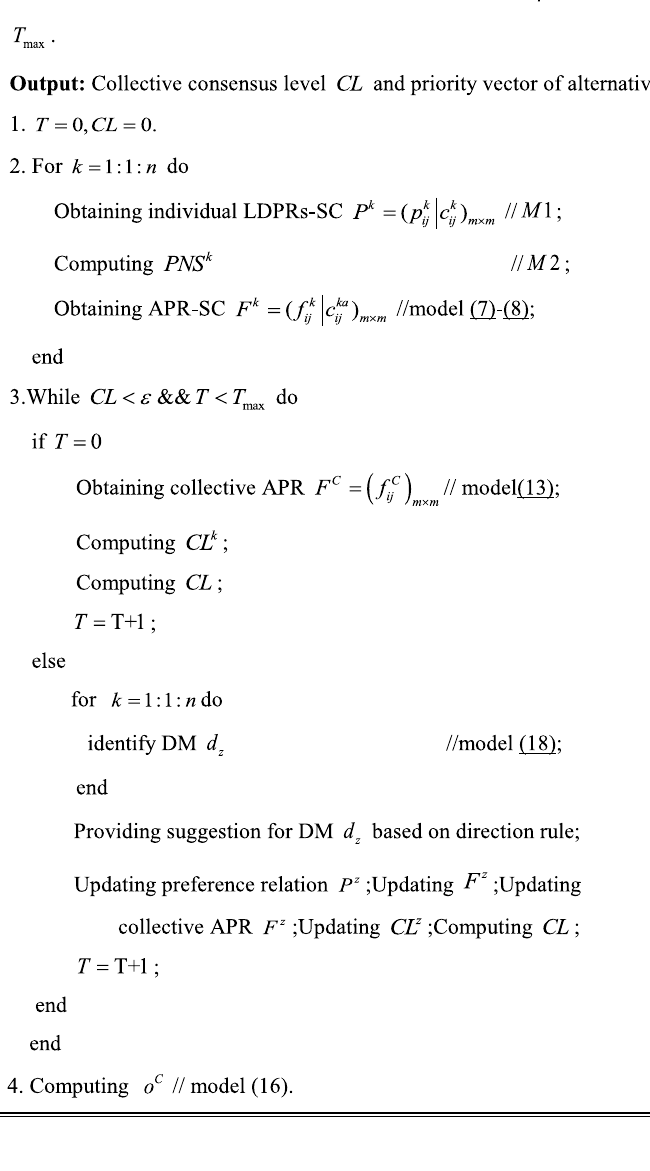
Table 1 Solution